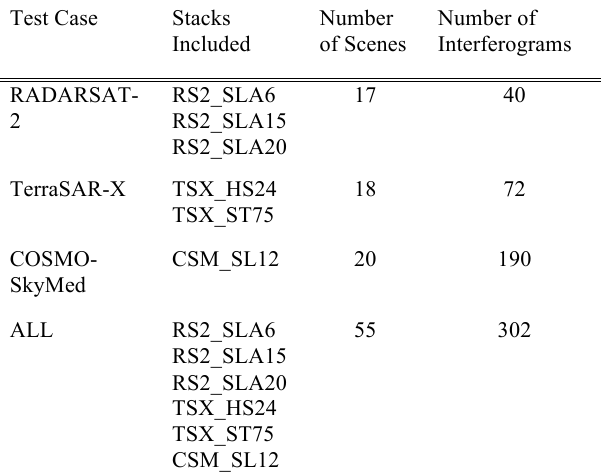
Table 2. Summary of SAR data stacks used in